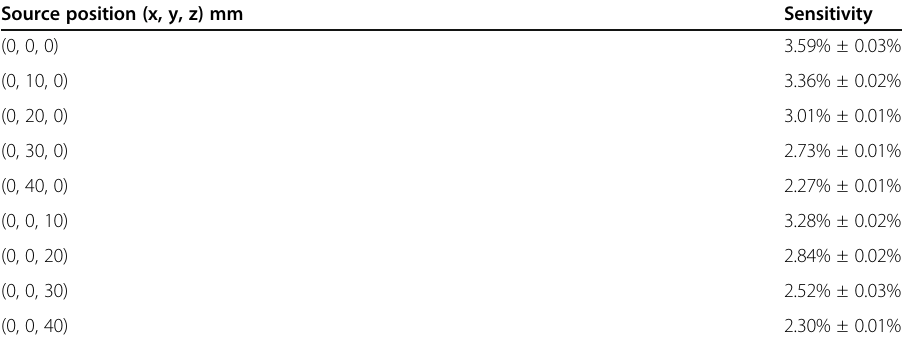
Table 3 Sensitivity at different positions Source position (x, y, z) mm